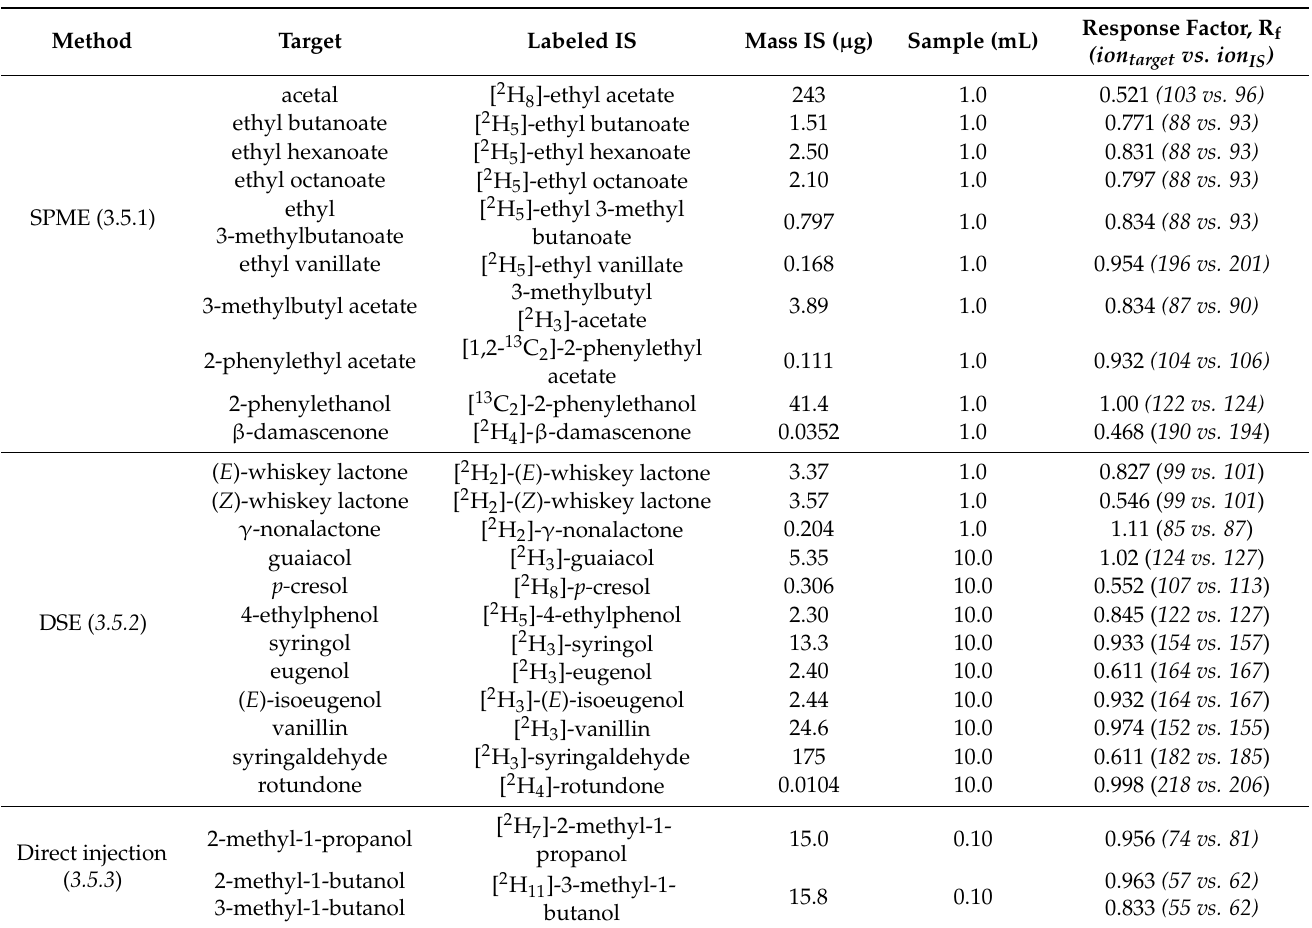
Table 6. Calibration table: target analytes, labeled internal standards, IS spike masses, sample volumes, MS ions, and response factors used for SIDA of